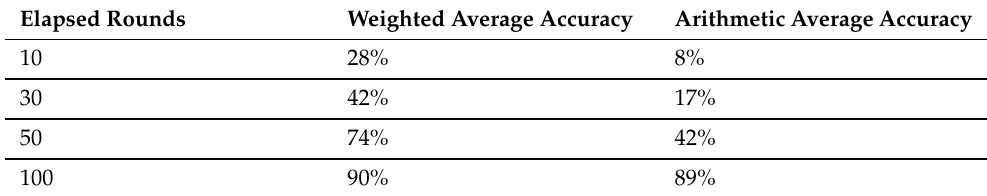
Table 5. Results obtained with cross-validation for 8